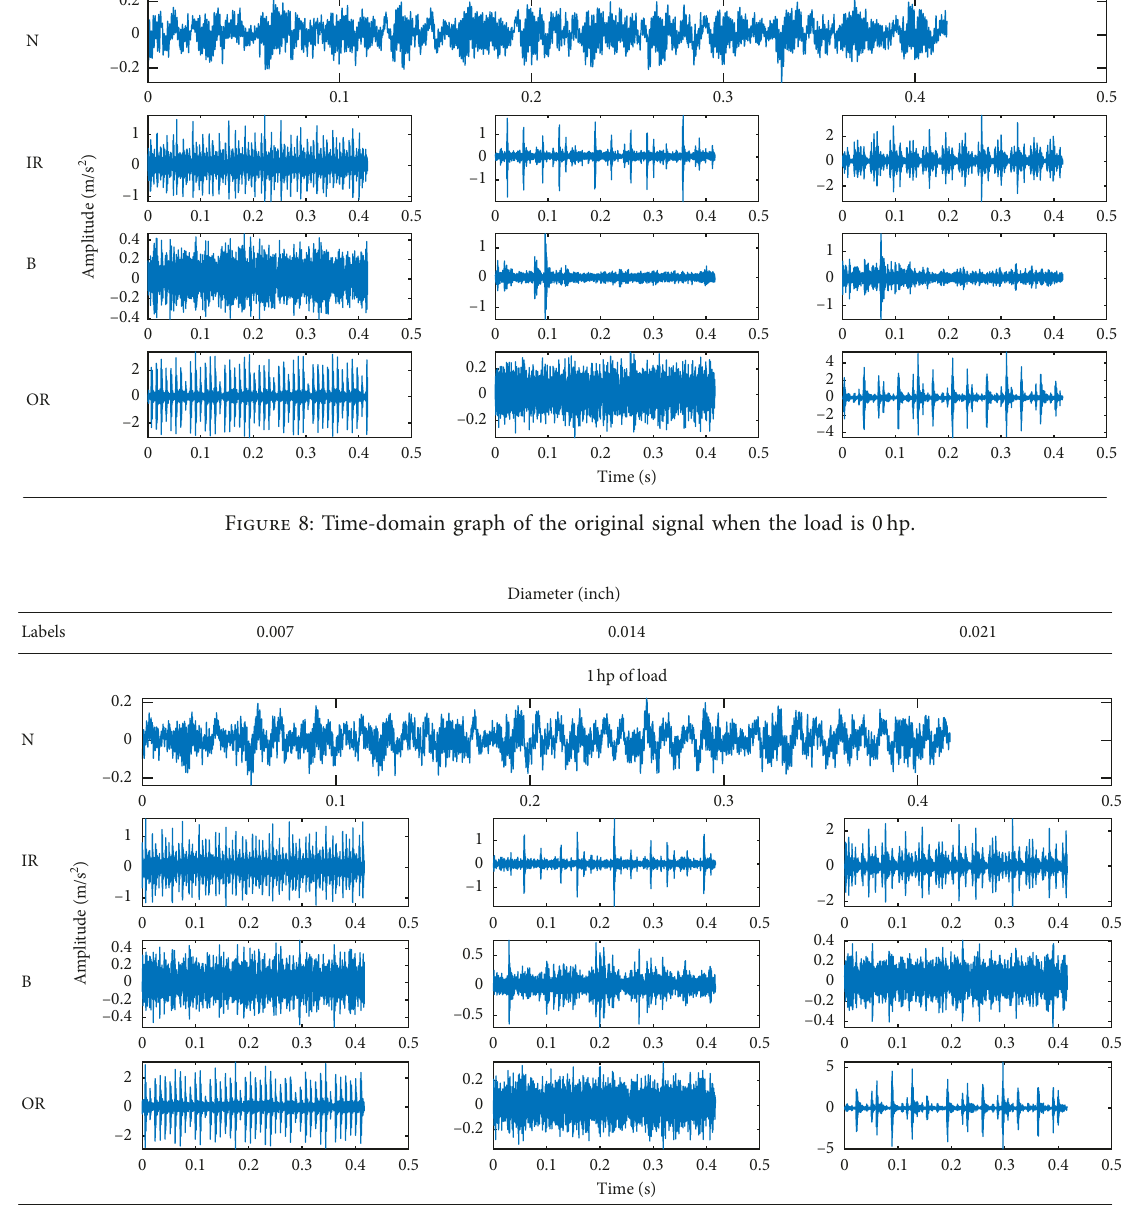
Figure 9: Time-domain graph of the original signal when the load is